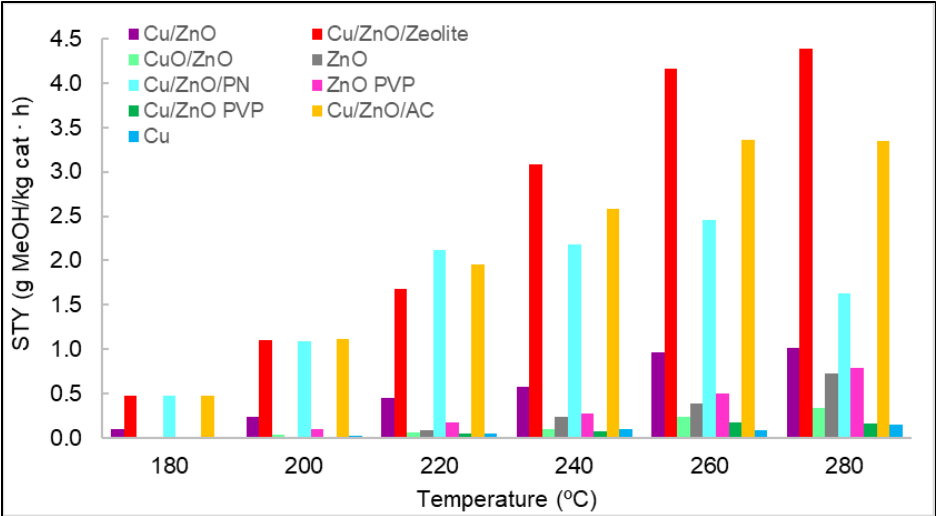
Figure 7. STY values for each catalyst at different temperatures and at a pressure of 15 bar.